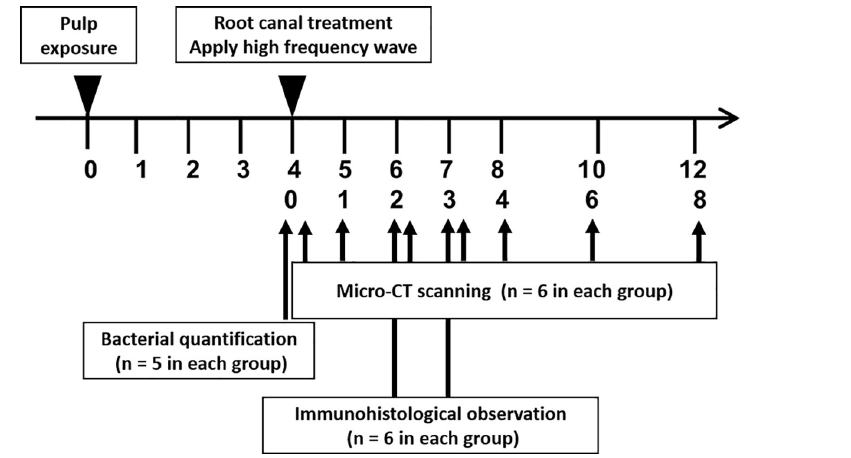
Fig 1. Experimental schedule of high-frequency wave root canal therapy in rat